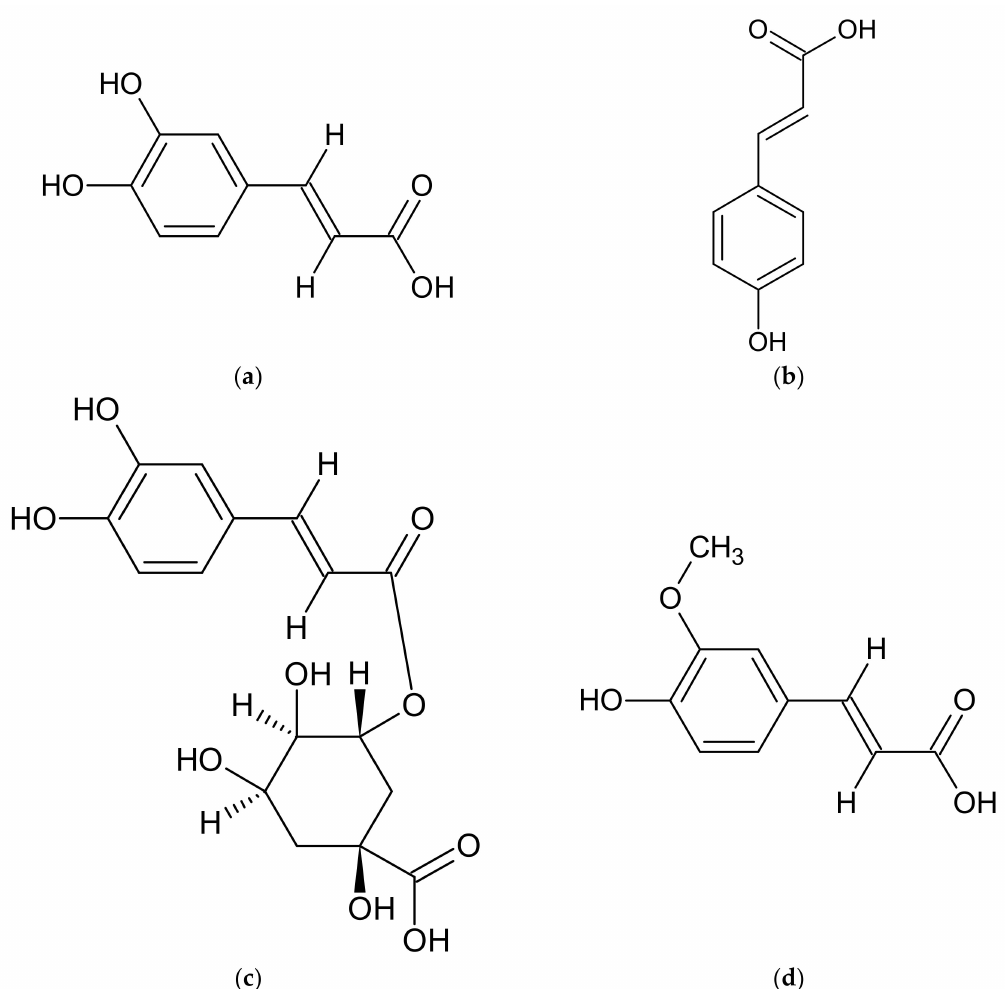
Figure 4. Chemical structure of phenolic acids found in Artemisia species: caffeic acid ( a ); p -coumaric acid ( b ); chlorogenic acid ( c ); ferulic acid ( d